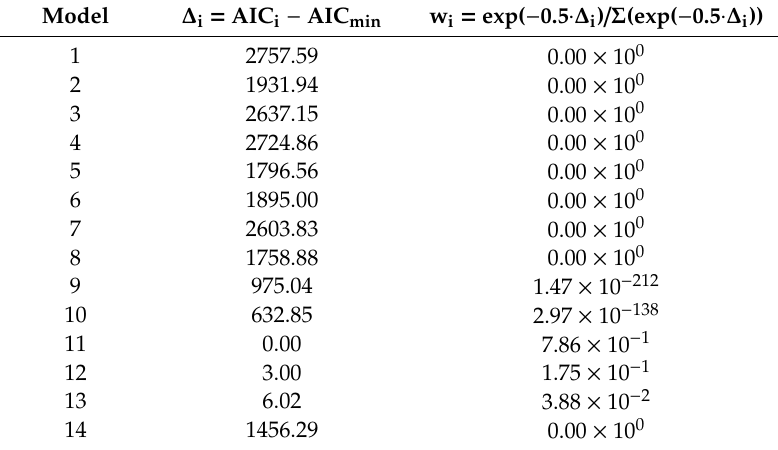
Table 3. Increments of the Akaike information criterion corrected for each model with respect to the best model (minimum), and the relative likelihood of each model expressed through its relative Akaike weight (w i